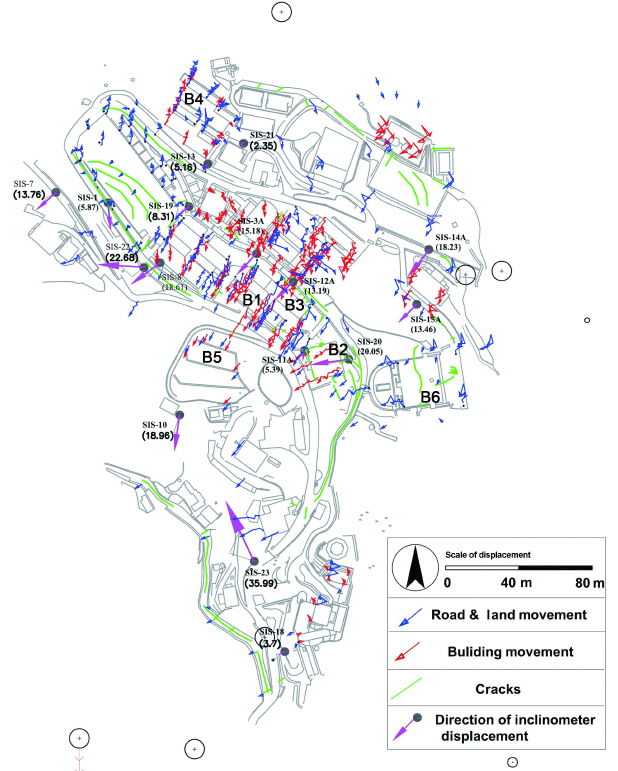
Figure 8. Displacement tracks and ground surface crack distribu- tion. The scale of displacement has been enlarged 200 times to high- light its tendency.